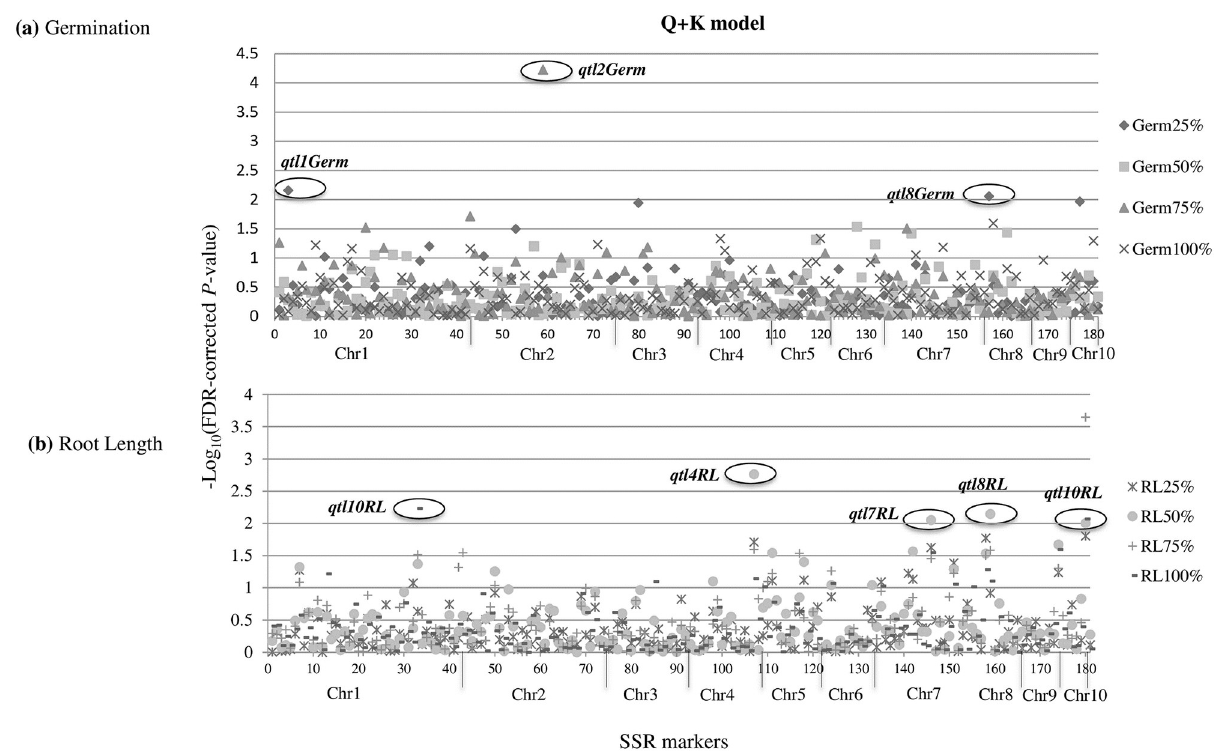
Fig 3. Linkage map generated using 151 SSR markers on 134 F 2 population. QTL analysis was performed on eight allelopathy related traits studied on germination and root length of lettuce plants exposed to water soluble extracts (WSE) from F 3 family lines. WSE was used in four different concentrations i.e. 25% ( $ ), 50% ( ◆ ), 75% ( ⚫ ) and 100% ( ❖ ).